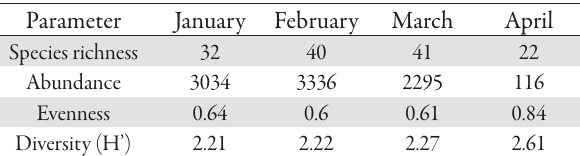
Tab. 5. Status of waterbirds across various months during present study